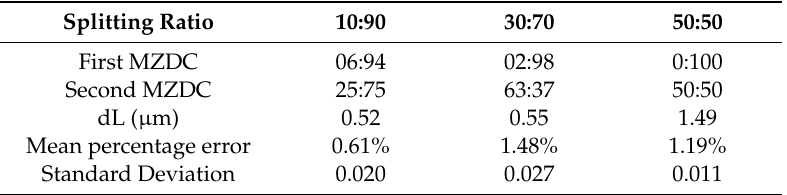
Table 4. Parameters design of Tandem